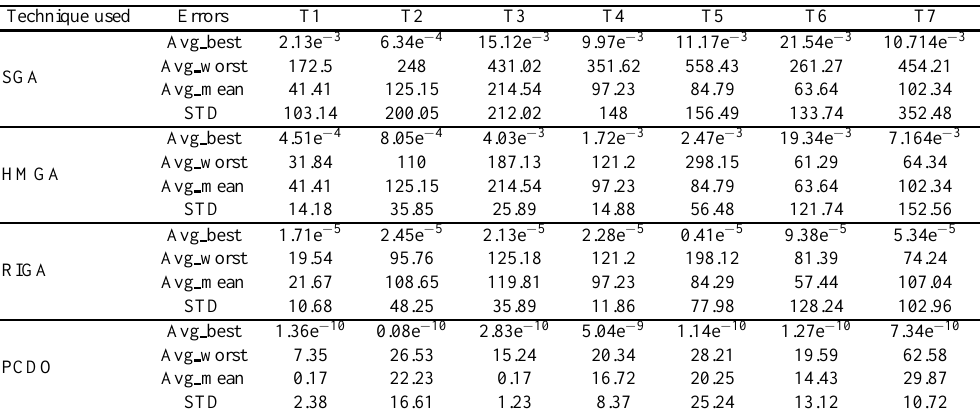
Table 4. Error Values Achieved for Problems F 4 .